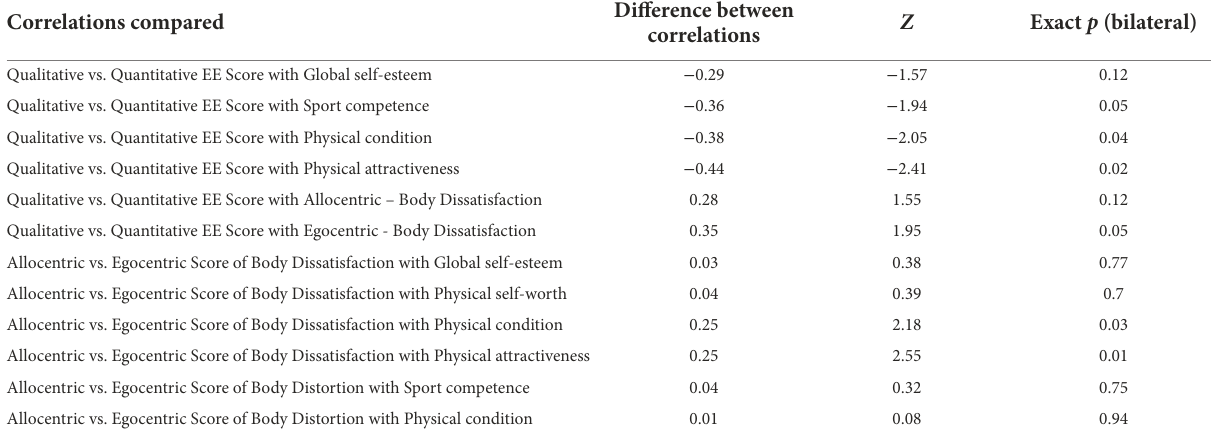
TABLE 3 Comparisons among pairs of correlations ( N =